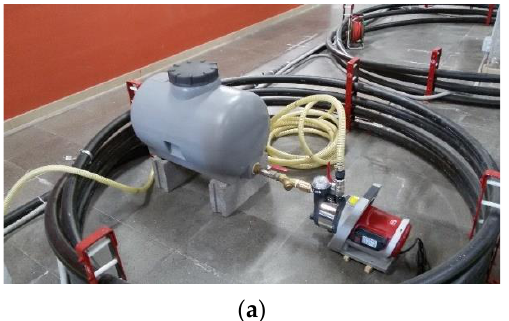
Figure 2. Overview of the experimental water distribution network ( a ), pumping system ( b ), and recirculation system ( c ).